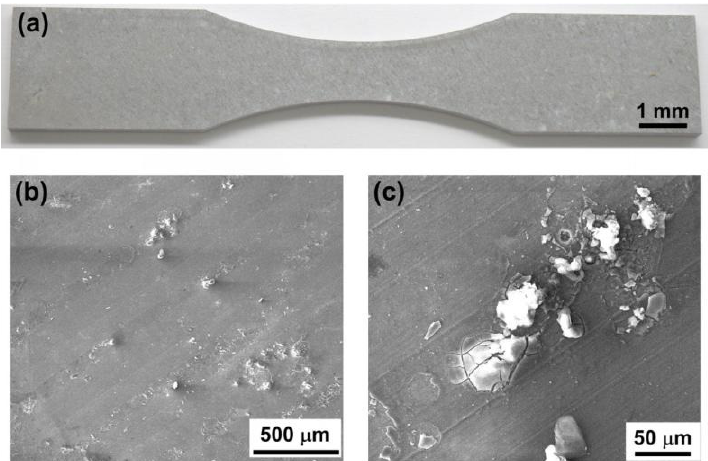
Figure 2. Surface morphologies of the 7085-T7452 aluminum alloy specimen exposed to an actual marine atmosphere for three months: ( a ) at a macroscopic scale; and ( b , c ) at a microscopic scale.